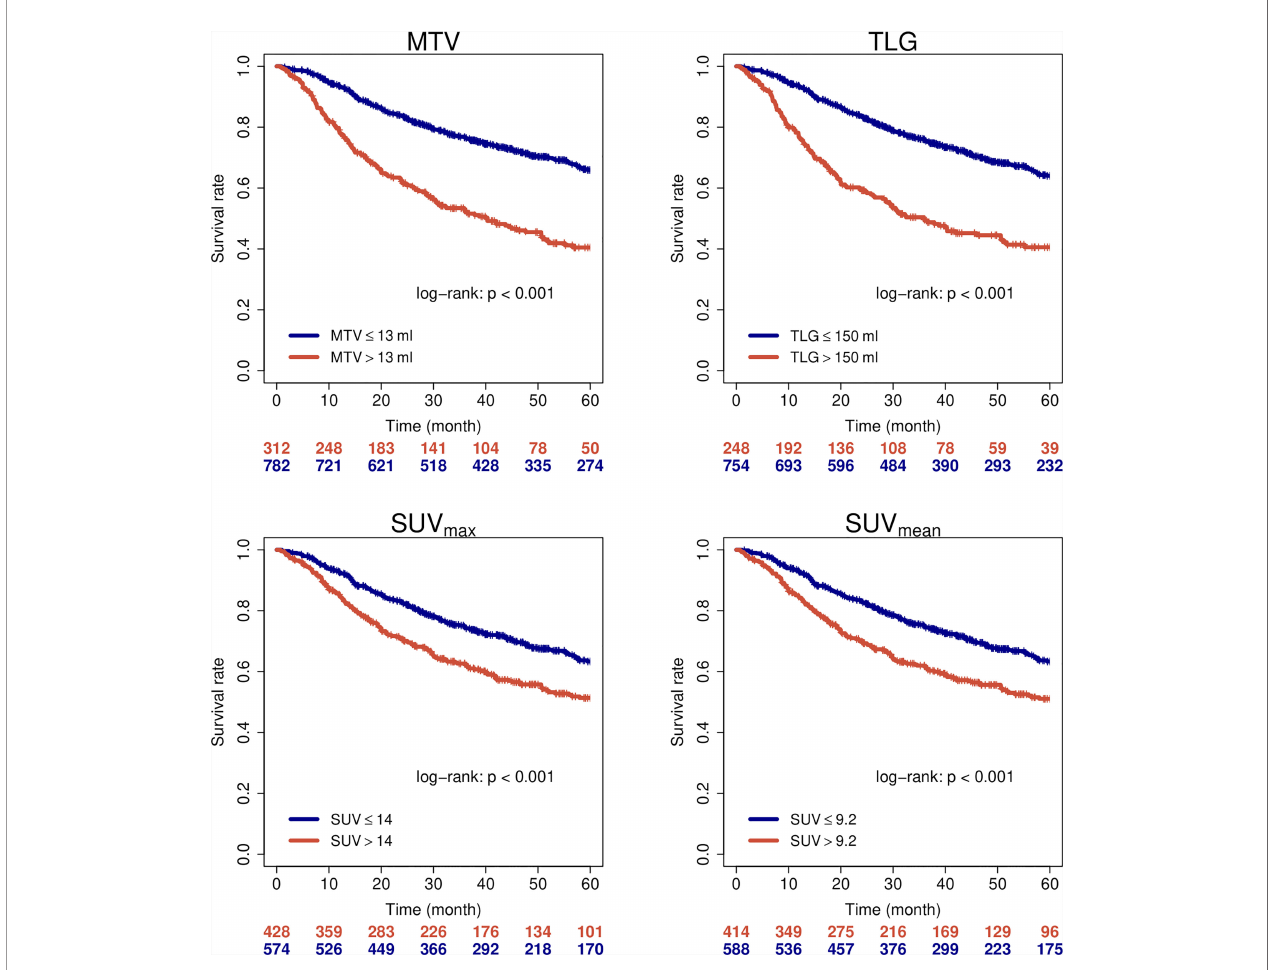
FIGURE 1 | Overall survival of all patients when strati fi ed by PET